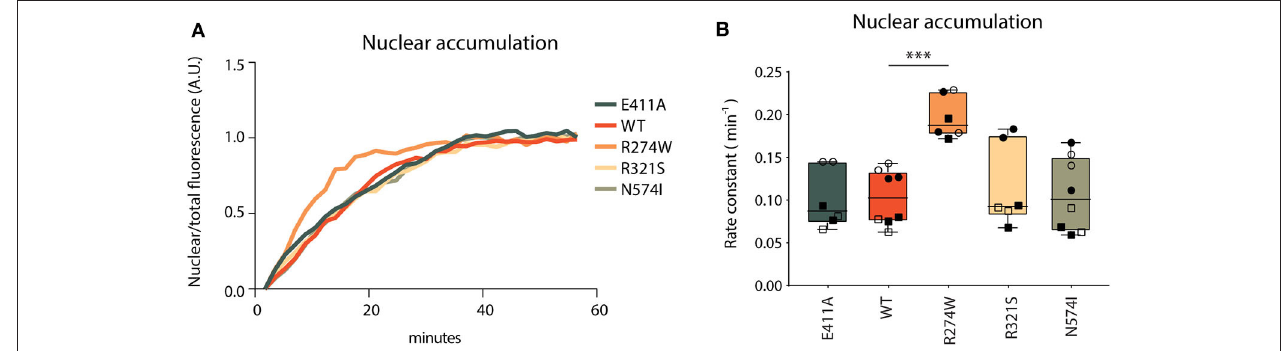
FIGURE 4 | Nuclear accumulation. (A) Nuclear accumulation of STAT1-GFP signal over a 60min time-lapse in stable STAT1 expressing HeLa cells, each sample was normalized on its last data point. Representative image of non-normalized data is reported in Supplementary Figure 6 . Since the Y701A control cannot be phosphorylated, the lack of nuclear accumulation is in line with expectations and no curve fitting was possible for this mutant ( Supplementary Figure 6 ; dotted gray line). (B) Nuclear accumulation rate constants, calculated as described in section Methods. The experiment was repeated at least two times for each STAT1 cell line and each biological repeat is represented by a different symbol. Statistical analysis was performed by comparing each other sample with STAT1 WT using One-Way ANOVA with Dunnett’s post-hoc test. Data are represented in box and whiskers plot, with all data points shown. *** P < 0.001.